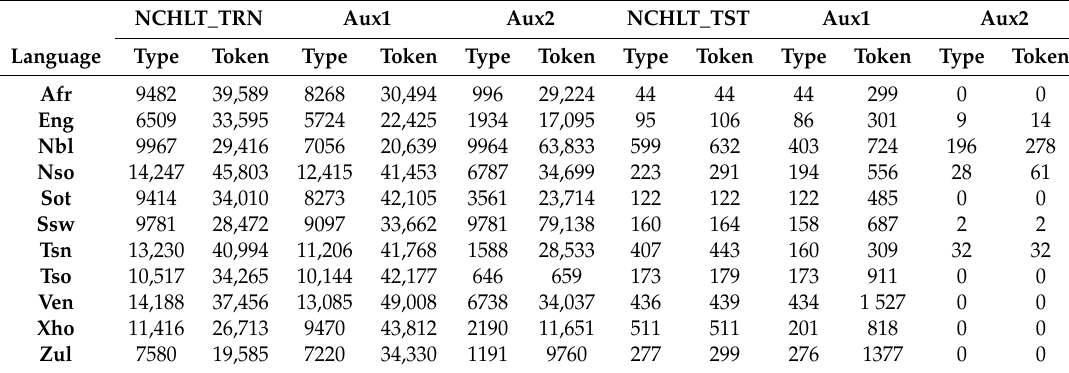
Table 2. Type and token counts for prompts only in NCHLT_TRN and only in NCHLT_TST. Aux1, Aux2: Type and token counts for prompts repeated in auxiliary data.